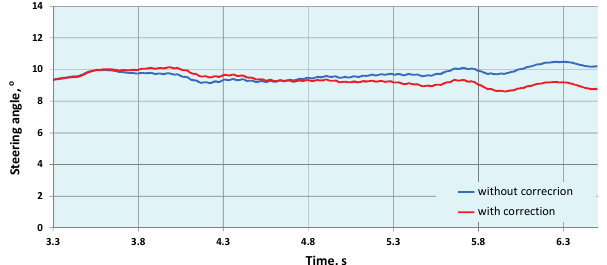
Fig. 6. Steering angle: real and corrected, during the test “ride on a circular path” The use of a simplified driver model allows for an tra- Fig. 4. Comparison of the preset and has made track of the vehicle physi- jectory adjustment which simulates the behavior of the cal model [3] human driver. Figure 7 shows the realized path, after which vehicle in scale was driving and simulated circular path after correction of steer